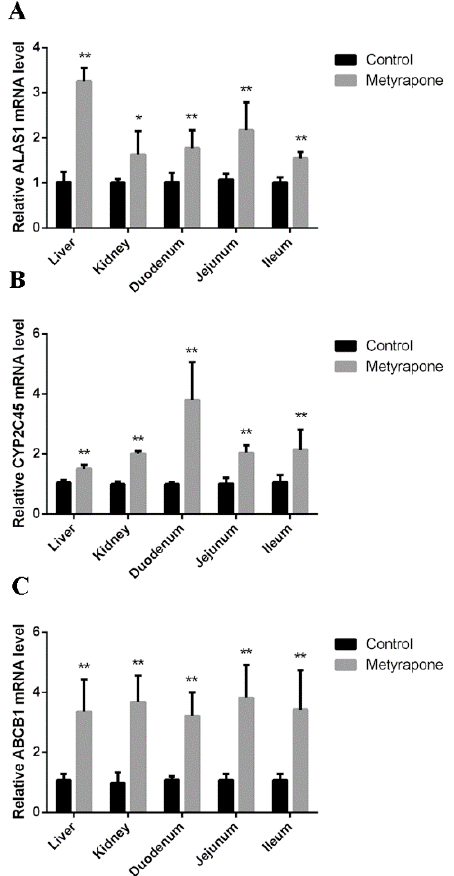
Figure 6. CXR-mediated induction of P-gp in chickens. RT-PCR analysis of ALAS1 ( A ), CYP2C45 ( B ) and ABCB1( C ) mRNA levels with or without the CXR activator metyrapone. Bars show means ± SD of three independent experiments. * p < 0.05, compared with the control group; ** p < 0.01, compared with the control group.